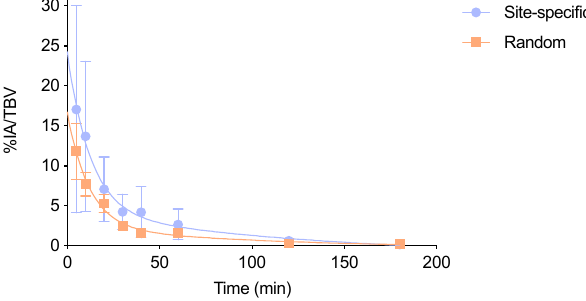
Figure 3. One phase decay fitting curve representing the % of injected activity (IA) per total blood volume (TBV) over time for the site-specifically and randomly labeled [ 67 Ga]Ga-NOTA-(hPD-L1) Nbs, showing a biological half-life of 12.4 min. and 10.8 min., respectively (NS).